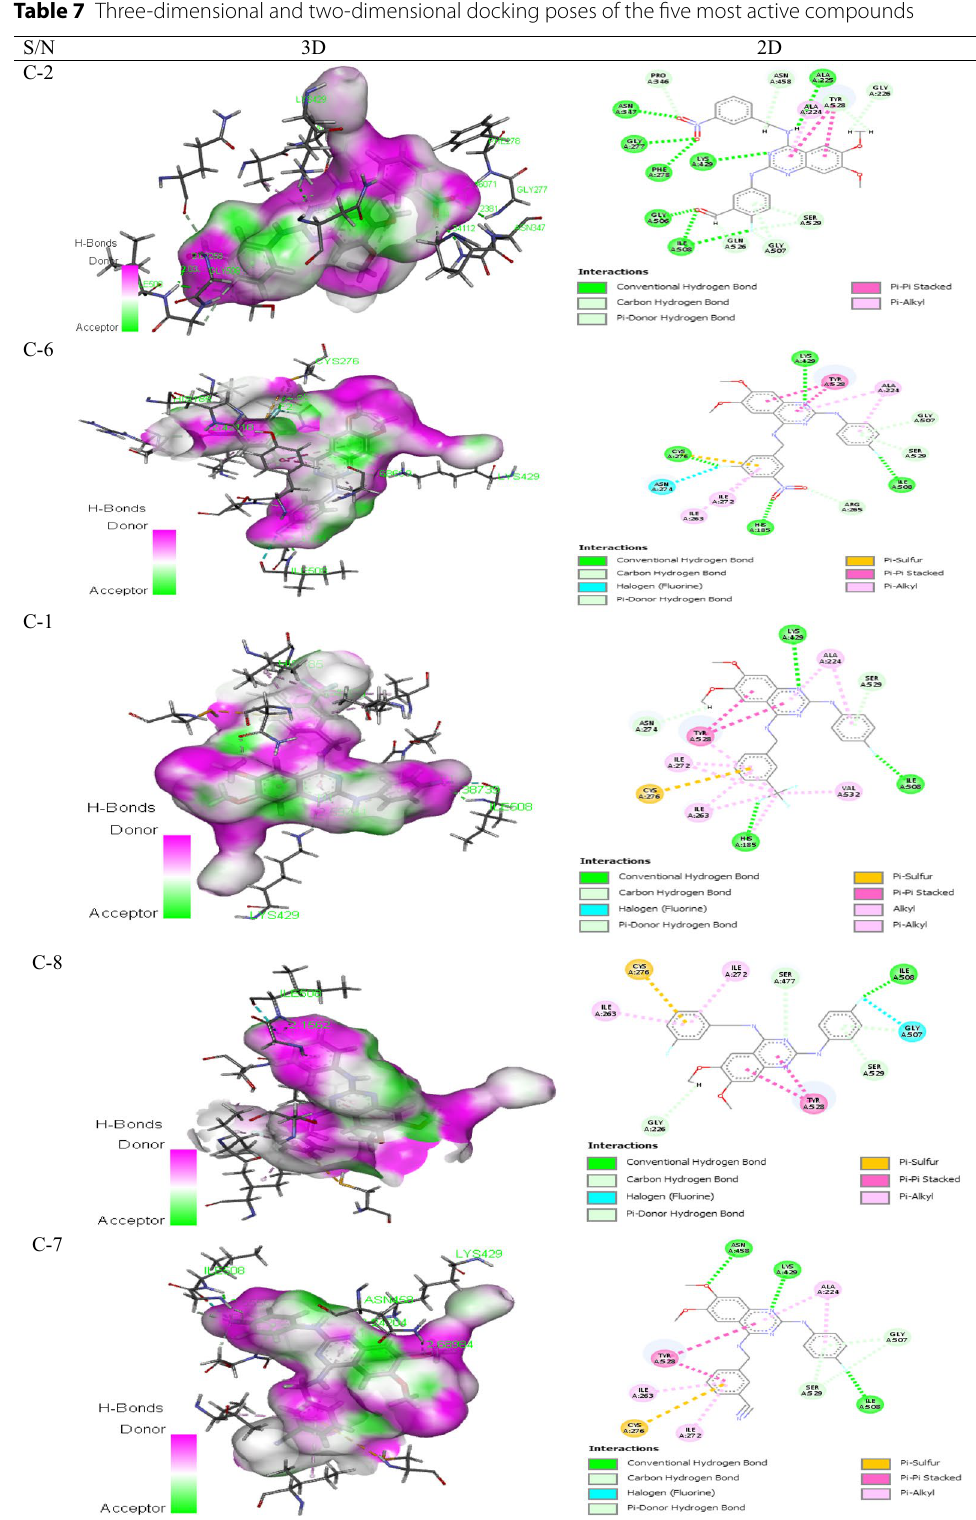
Table 7 Three-dimensional and two-dimensional docking poses of the five most active